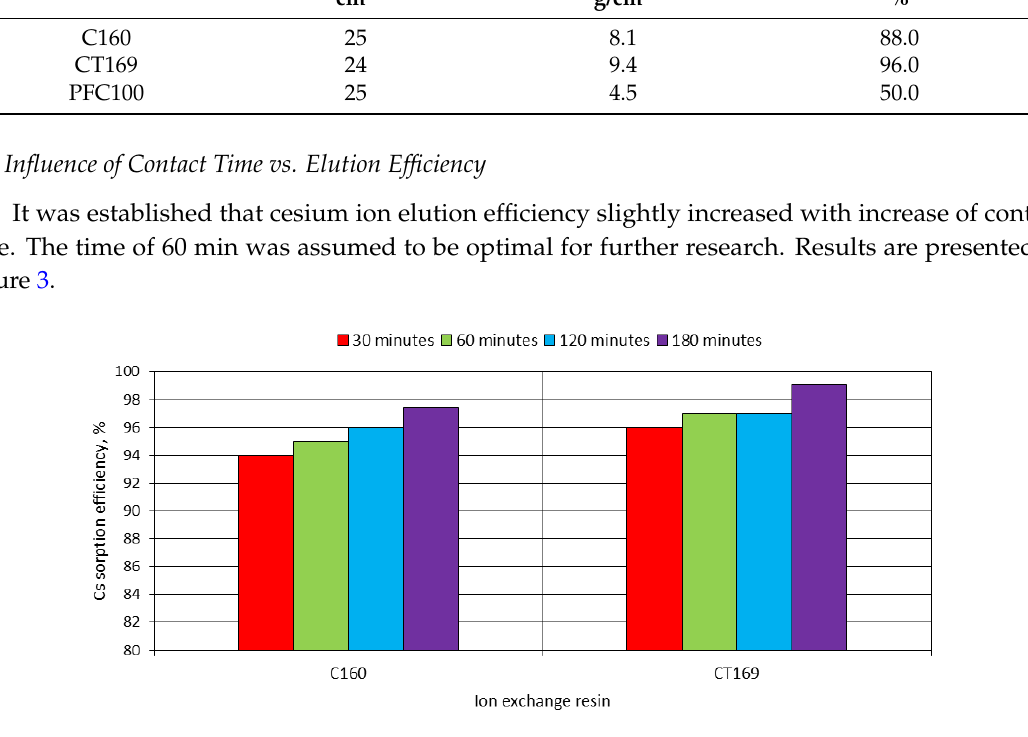
Figure 3. Influence of contact time on cesium ion elution efficiency.